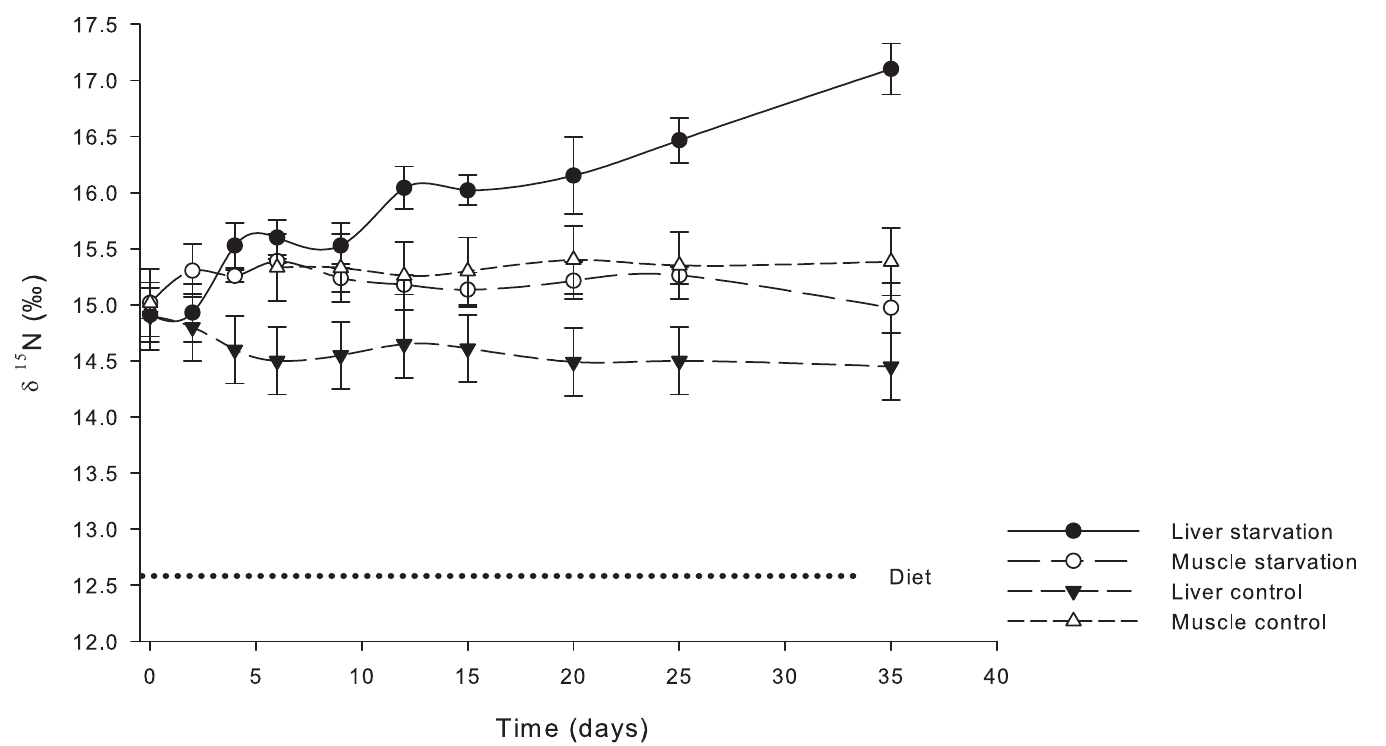
Fig 2. δ 15 N (‰) in bulk muscle and liver tissues of S . lalandi during 35 days of starvation. Liver starvation, Muscle starvation, Liver control and Muscle control, averageand